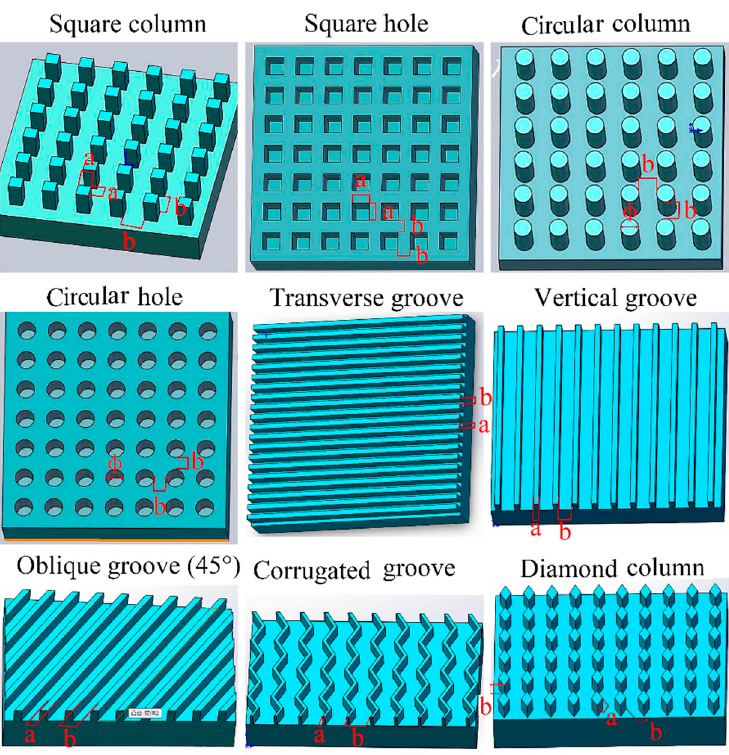
Figure 2. Surface texture designs.